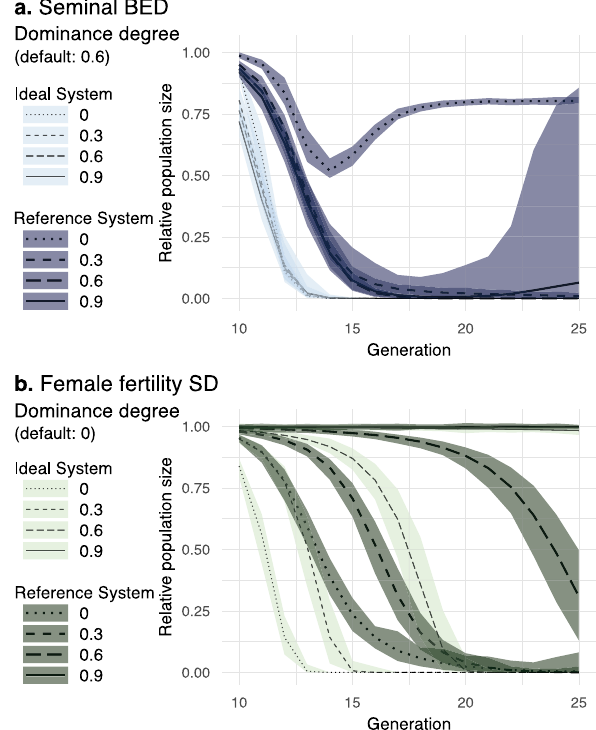
Figure 4. Impact of Dominance degree . Relative population size from generation 10 to 25 is shown with ideal and reference drive parameters for sBED ( a ) and ffSD ( b ) using in each case different values of Dominance degree . Lines represent the 100-simulations mean value while the colored envelopes stand for the maximum and minimum